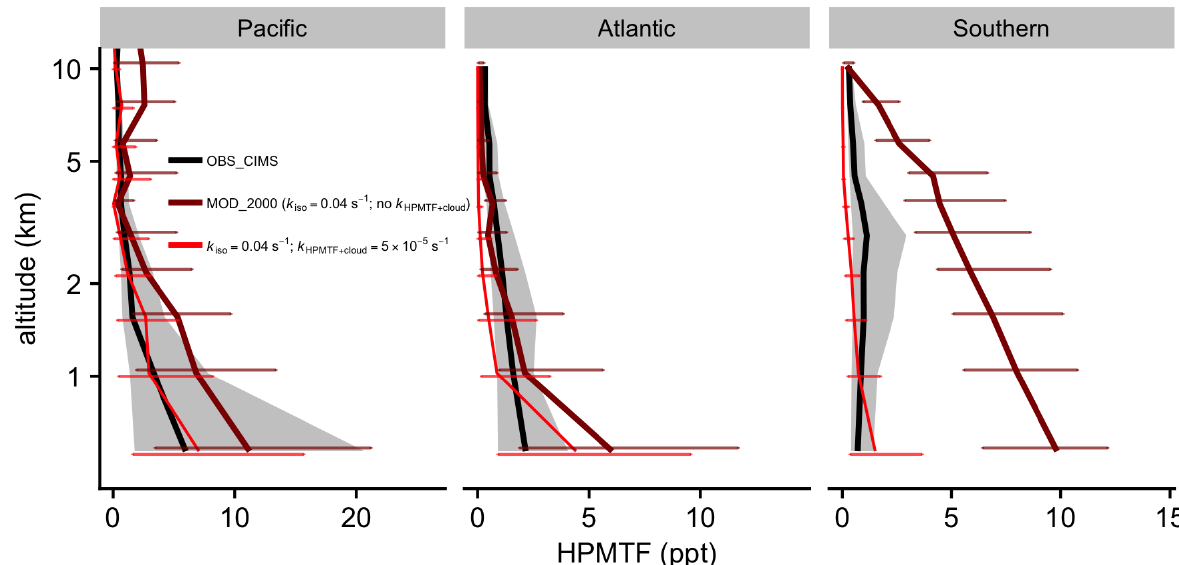
Figure 9. Measured (ATom) and modeled values of HPMTF are vertically binned. The thick lines show the medians. Error bars and gray shadings indicate that the data ranged between corresponding upper and lower quantiles. The thin red line indicates the results from a